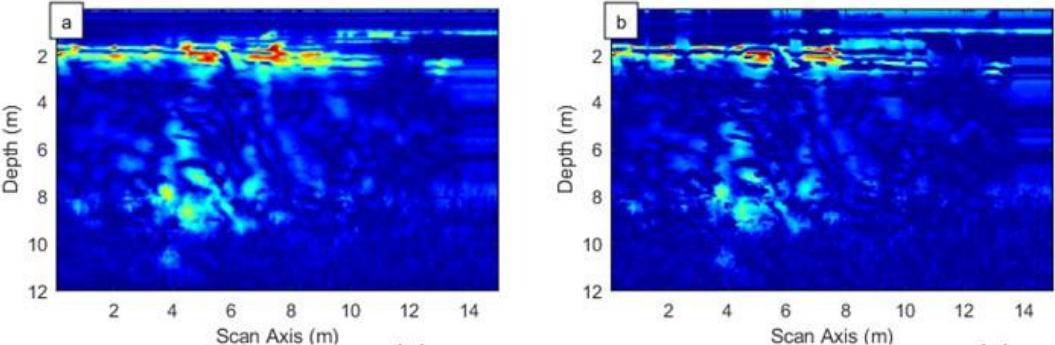
Figure 15. Frequency division section with EMD and EEMD: ( a ) Frequency division section at 80 kHz with EMD; and, ( b ) Frequency division section at 80 kHz with